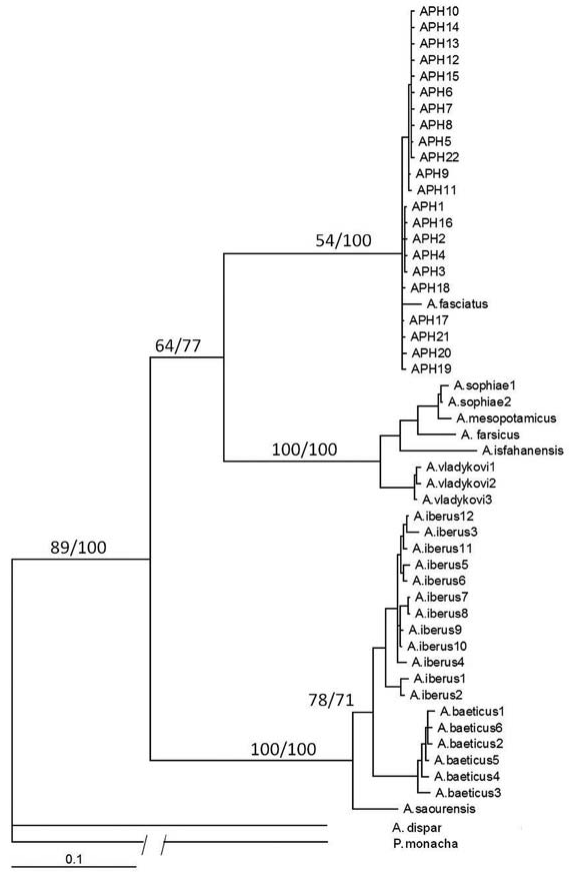
Fig. 3. – BAY phylogram of the cyt b haplotypes obtained in this study (symbols in capital letters), together with those retrieved from GenBank (first data set). Numbers at nodes represent Bayesian pos- terior probabilities and maximum parsimony branch support values,